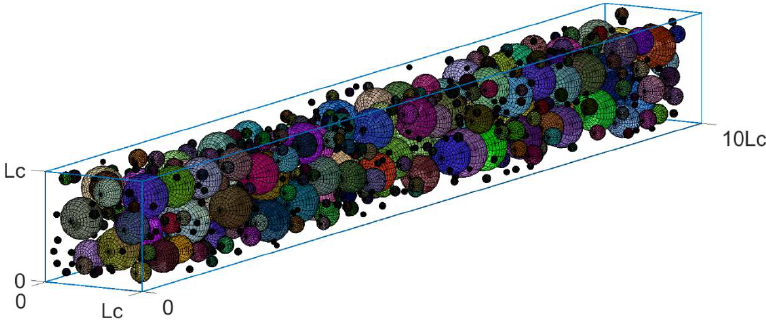
Figure 8. 32% VBP virtual bimrock model (H = 130 mm, B = 130 mm, L = 1300 mm). LBPs were computed from 1000 equidistant simulated model boreholes, ϑ. The number